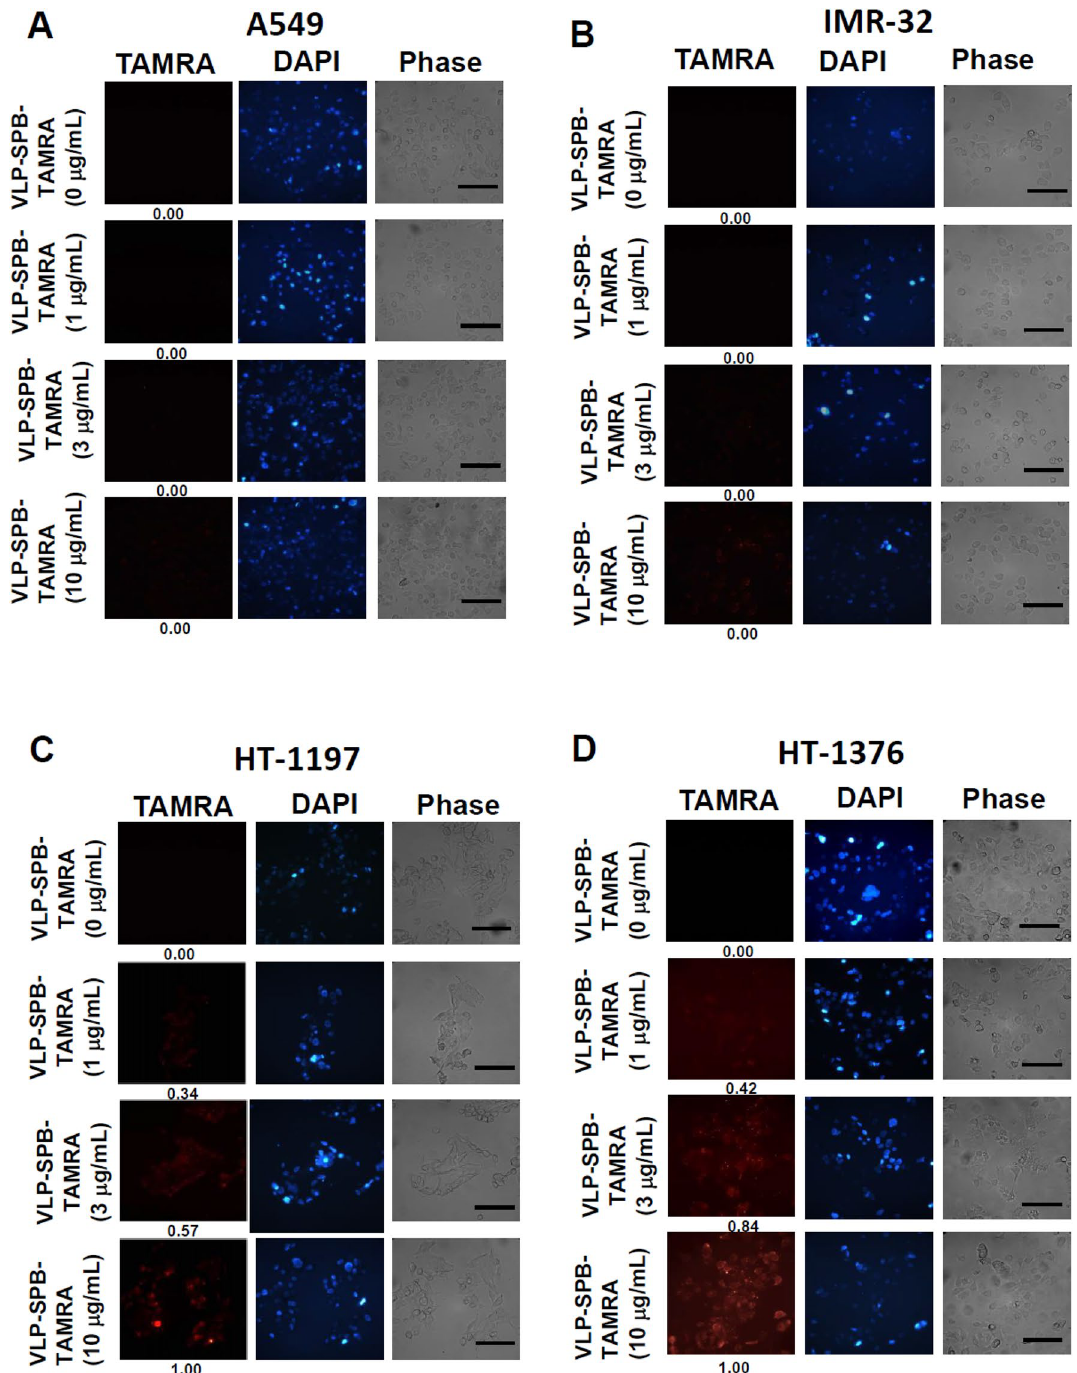
Figure 3. Determination of the binding specificity of JCPyV VLP-SPBs. JCPyV VLP-SPB-TAMRA at different concentrations was used to bind ( A ) A549 lung cancer cells, ( B ) IMR-32 neuroblastoma cells, ( C ) HT-1197 bladder cancer cells and ( D ) HT-1376 bladder cancer cells. The cells were observed under a fluorescent microscope. Scale bar: 100